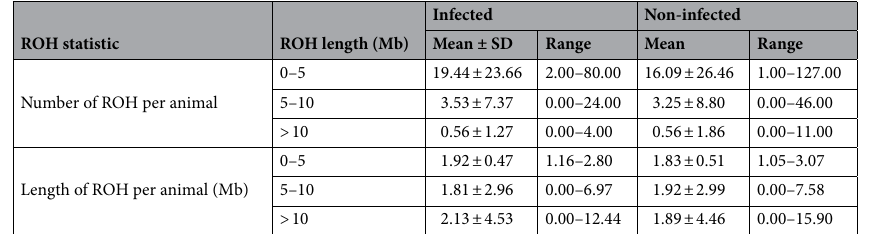
Table 2. Number and length of ROH for each cohort of autochthonous Tunisian sheep for each ROH length